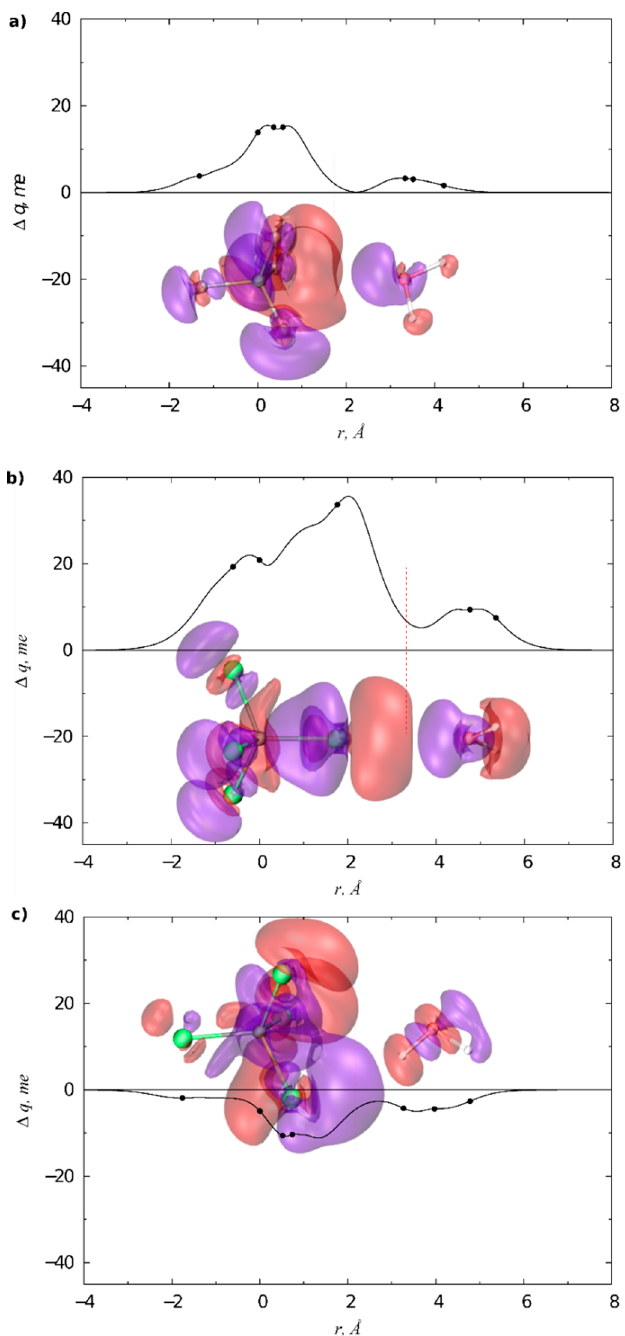
Figure 4. 3D isodensity plots (cut-off = ±0.15 me/bohr 3 , negative/positive values in red/violet) and correspondent CD curves of the electron density change due to the intermolecular interaction for the CF 4 -H 2 O ( a ) and CCl 4 -H 2 O systems at the global minimum optimized geometries ( b , c ). Dots correspond to the projection of the nuclei positions on the z axis. The axis origin is at the tetrahedral carbon. The vertical dashed lines mark the isodensity boundary between the fragments. (Reproduced from Reference 57 with permission from the Centre National de la Recherche Scientifique (CNRS) and The Royal Society of Chemistry).